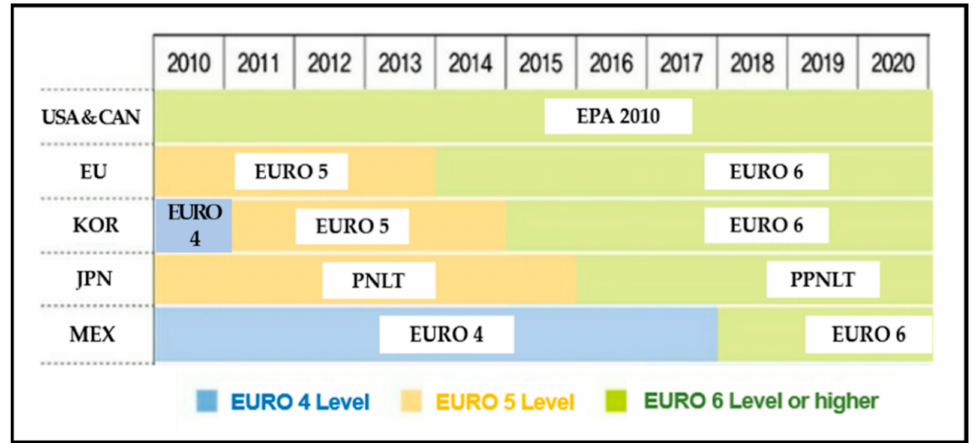
Figure 4. Level of environmental regulations for commercial vehicles in major oecd countries. Sources: Korea Economic Research Institute, 2017